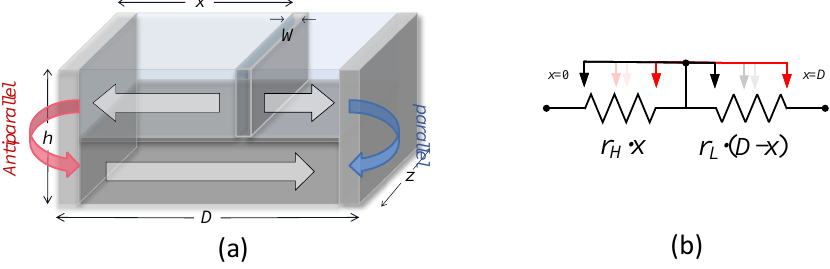
Figure 1. Spin memristor. ( a ) Structure diagram. ( b ) Equivalent circuit